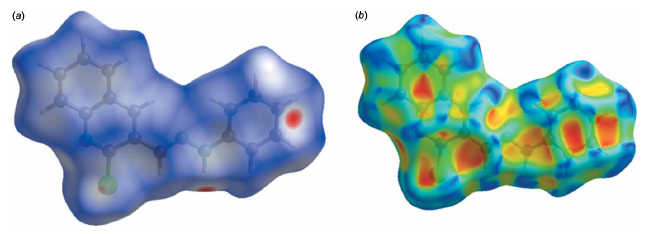
Figure 5 Aview of the Hirshfeld surface of compound 5 mapped over ( a ) d norm and ( b ) shape index.